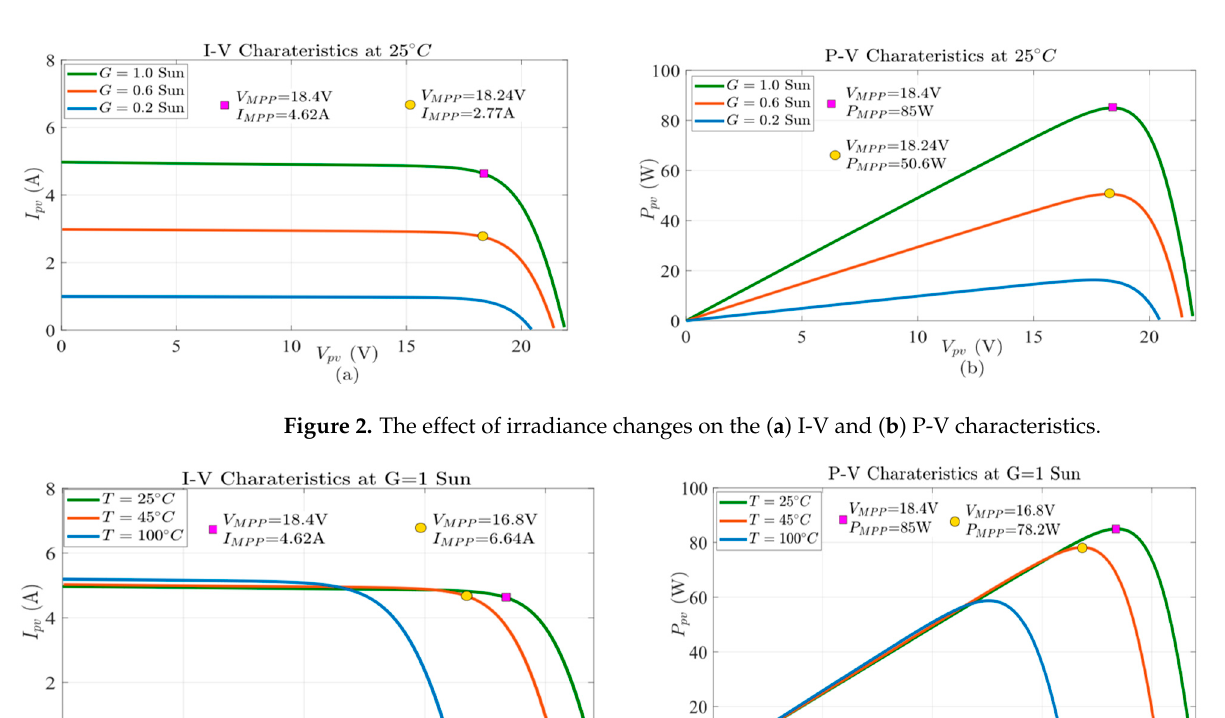
Figure 3. The effect of temperature change on the ( a ) I-V and ( b ) P-V characteristics.